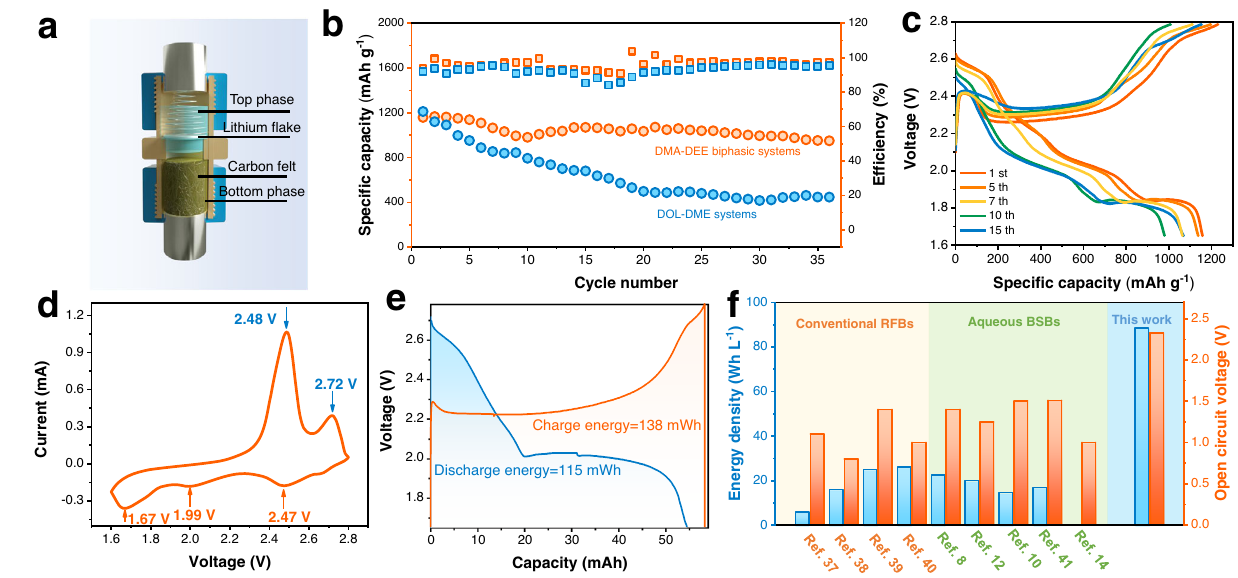
Fig.5|ElectrochemicalperformanceofLi-SBSBs.a SchematicillustrationofLi-S BSBs. b CyclingperformanceofLi-Sbatteriesusingbiphasicelectrolytesystemand conventionalelectrolyte. c Charge/dischargepro fi lesofaLi-SBSB. d CVcurvesofa Li-SBSBatascanningrateof0.1mVs − 1 . e CapacityperformanceoftheLi-SBSBwith